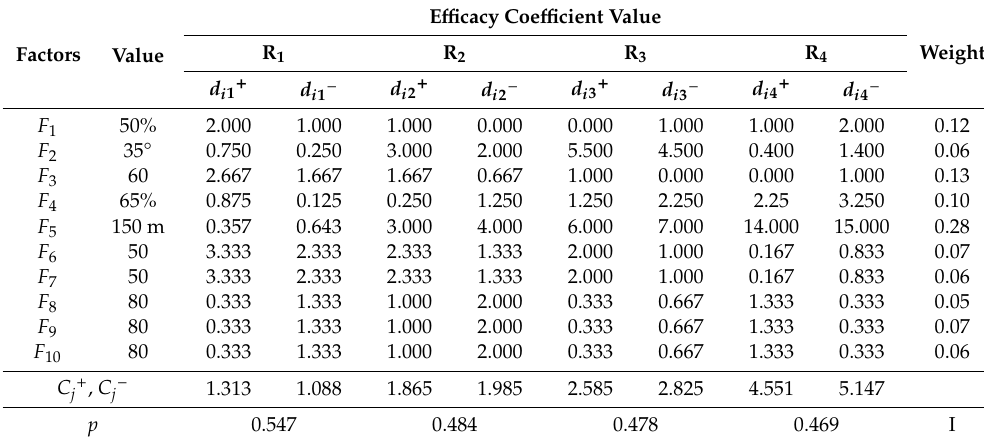
Table 8. Dynamic evaluation for water and mud